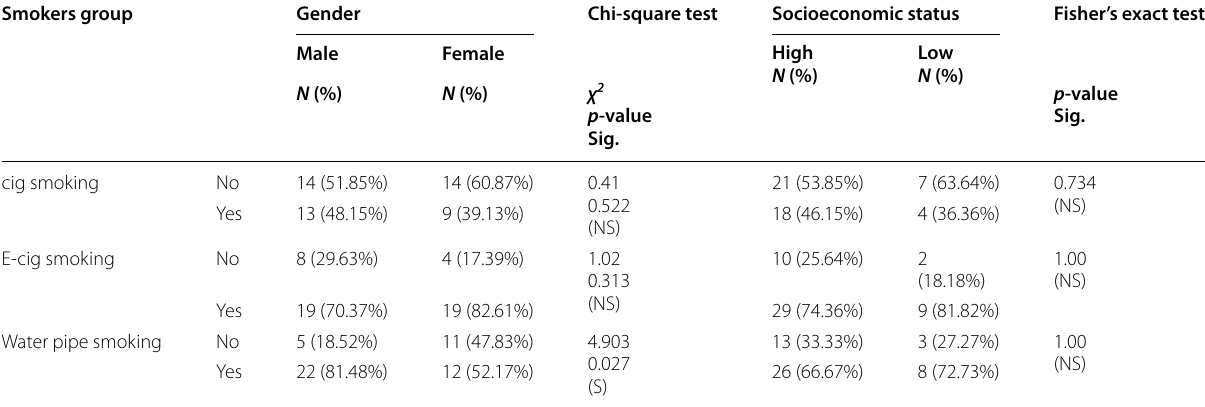
Sig. , significant; S , significant; NS , non-significant